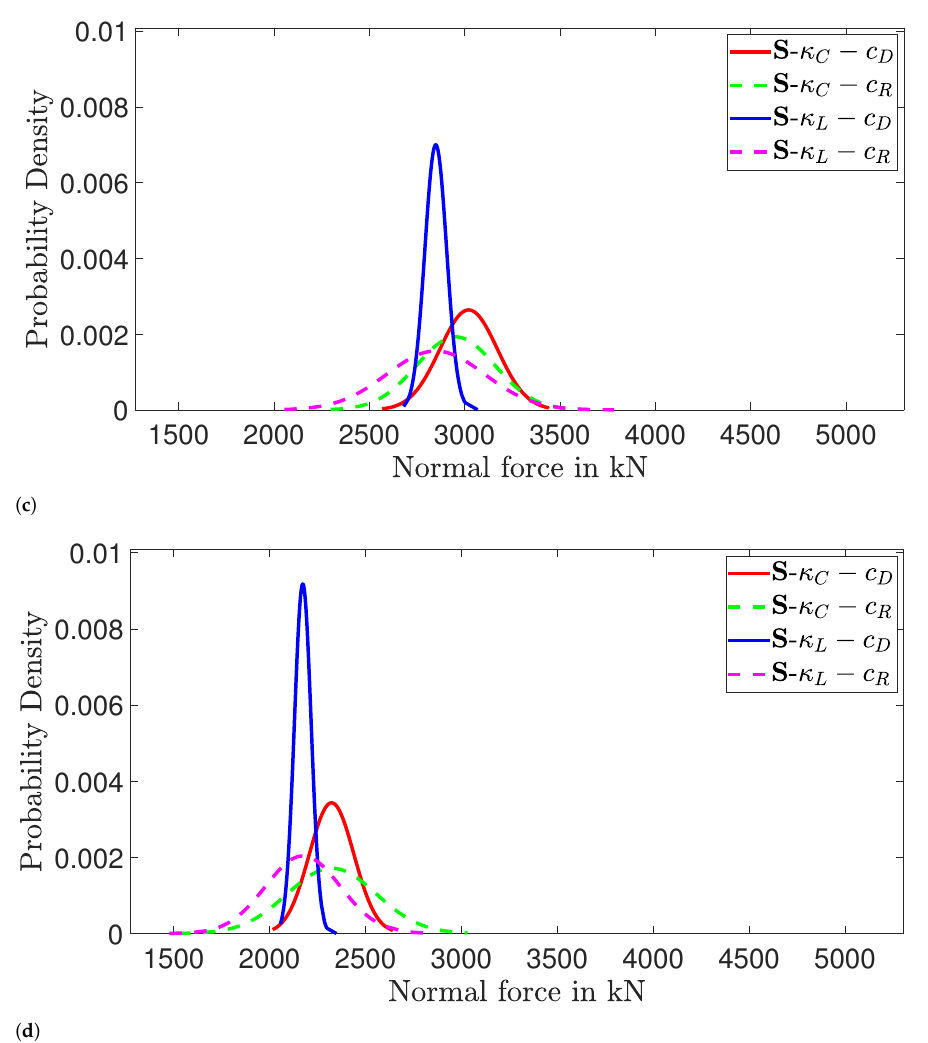
Figure A1. PDFs of the Normal force of the settlement in kN for non-porous medium. κ L , κ C stands for the linear and constant distribution for κ , respectively, and c D , c R stands for the deterministic and random distribution for c, respectively. Subplot ( a – d ) stand for eccentricity 0, h